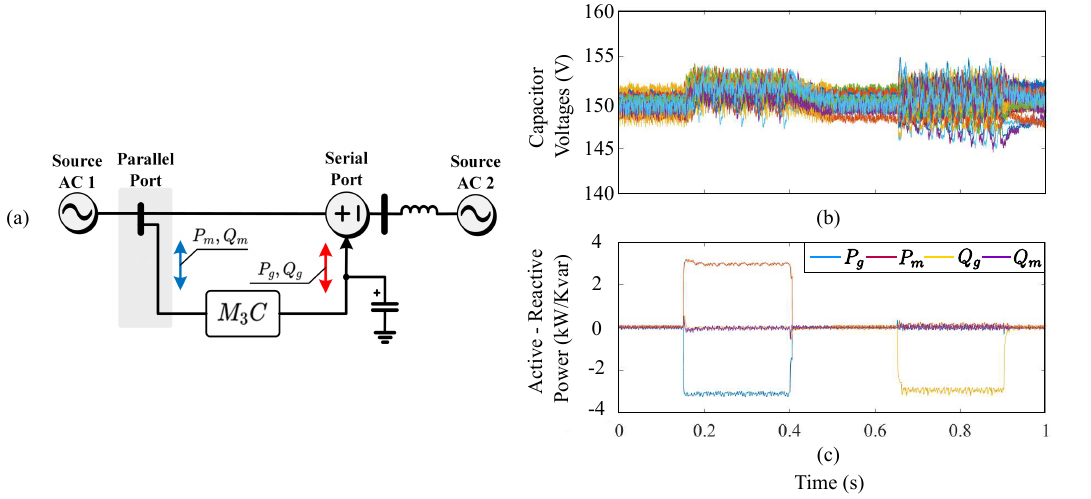
Figure 17. M 3 C -based UPFC. ( a ) Topology. ( b ) Floating capacitor voltage results. ( c ) Active and reactive power. Based on